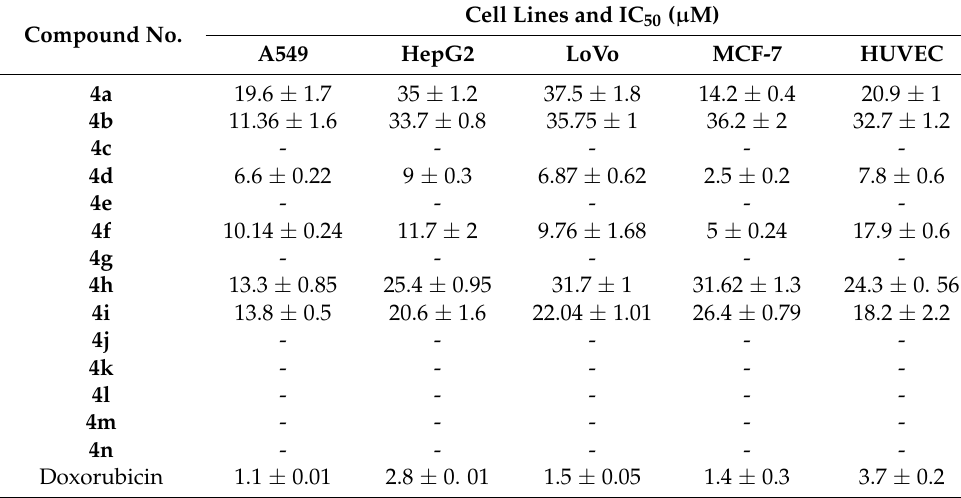
Table 1. Cytotoxic activity, expressed as IC 50 , of synthetic compounds 4a – n and doxorubicin against different cancer cell lines. Cell Lines and IC 50 ( µ M) Compound No. A549 HepG2